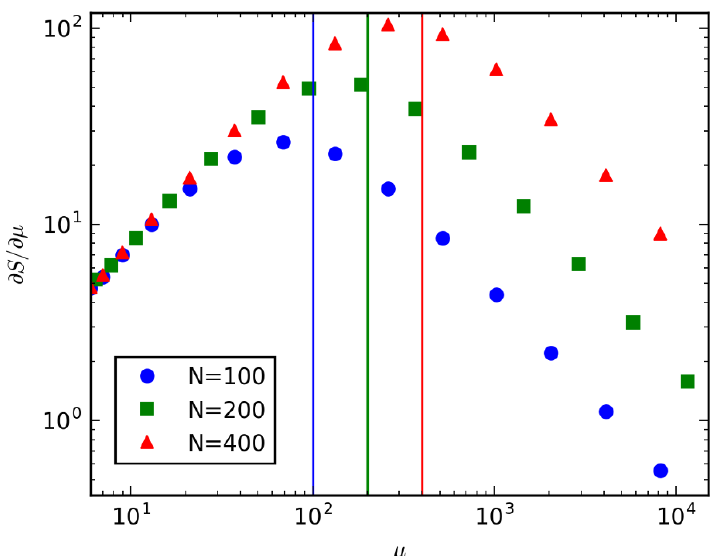
Figure 8 . Derivative of entanglement entropy with respect to (cid:22) , evaluated at (cid:18) = (cid:25) various points represent di(cid:11)erent N , with vertical lines at those values to illustrate the turnover at (cid:22) (cid:24) N .